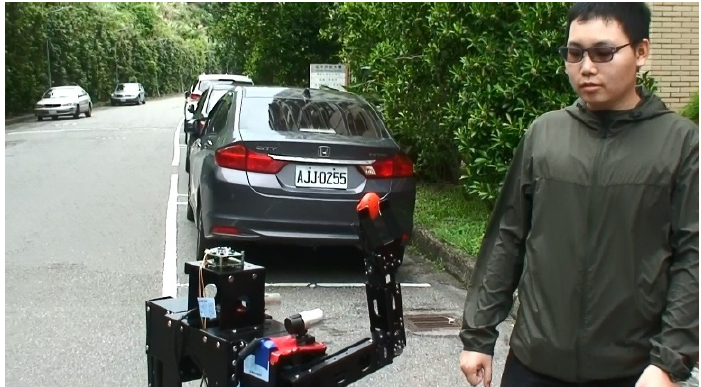
Figure 31. The robot activated the alarm and stopped moving.